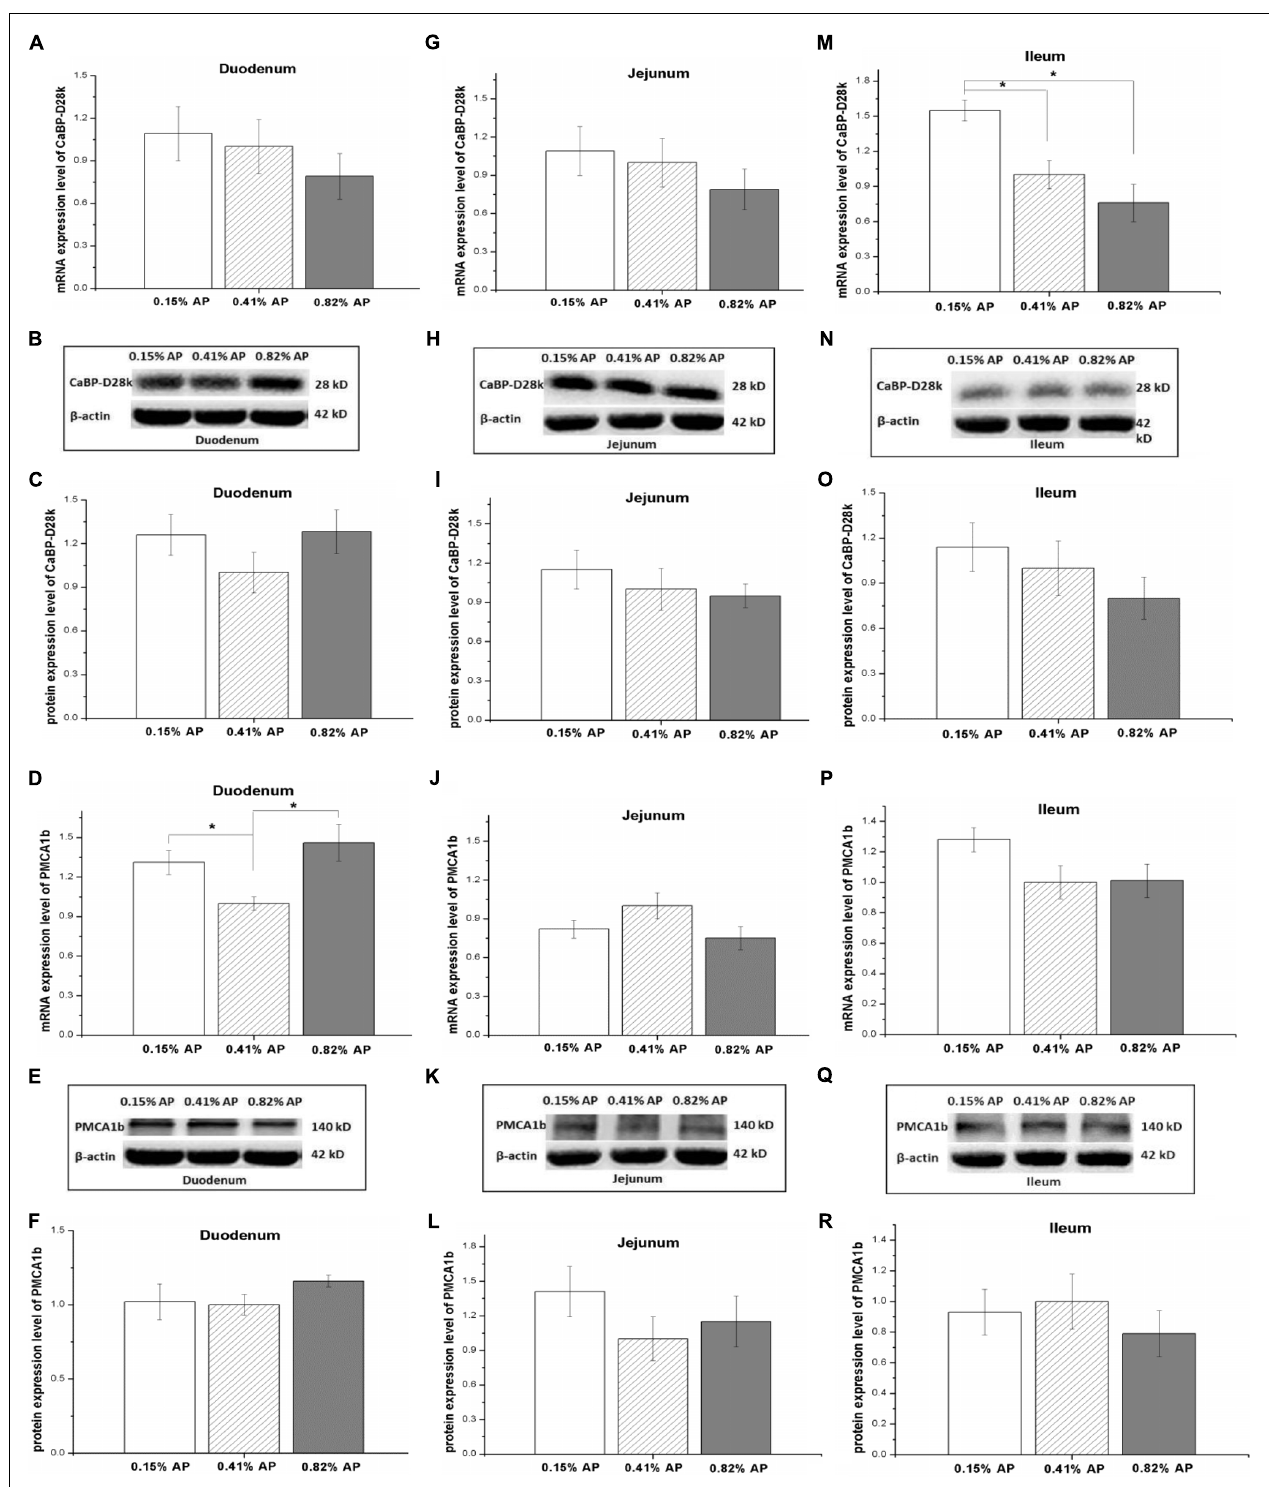
FIGURE 3 | Effects of dietary available phosphorus levels (AP, 0.15, 0.41, and 0.82%) on mRNA and protein expression levels of Calbindin-D28k (CaBP-D28k) and plasma membrane calcium ATPase 1b (PMCA1b) in small intestine of laying hens. Duodenum (A–F) ; jejunum (G–L) ; ileum (M–R) . Data were presented as means ± SEM ( n = 8); ∗ P <